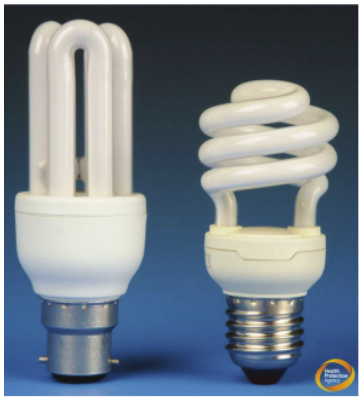
Figure 1: Single envelope CFLs.